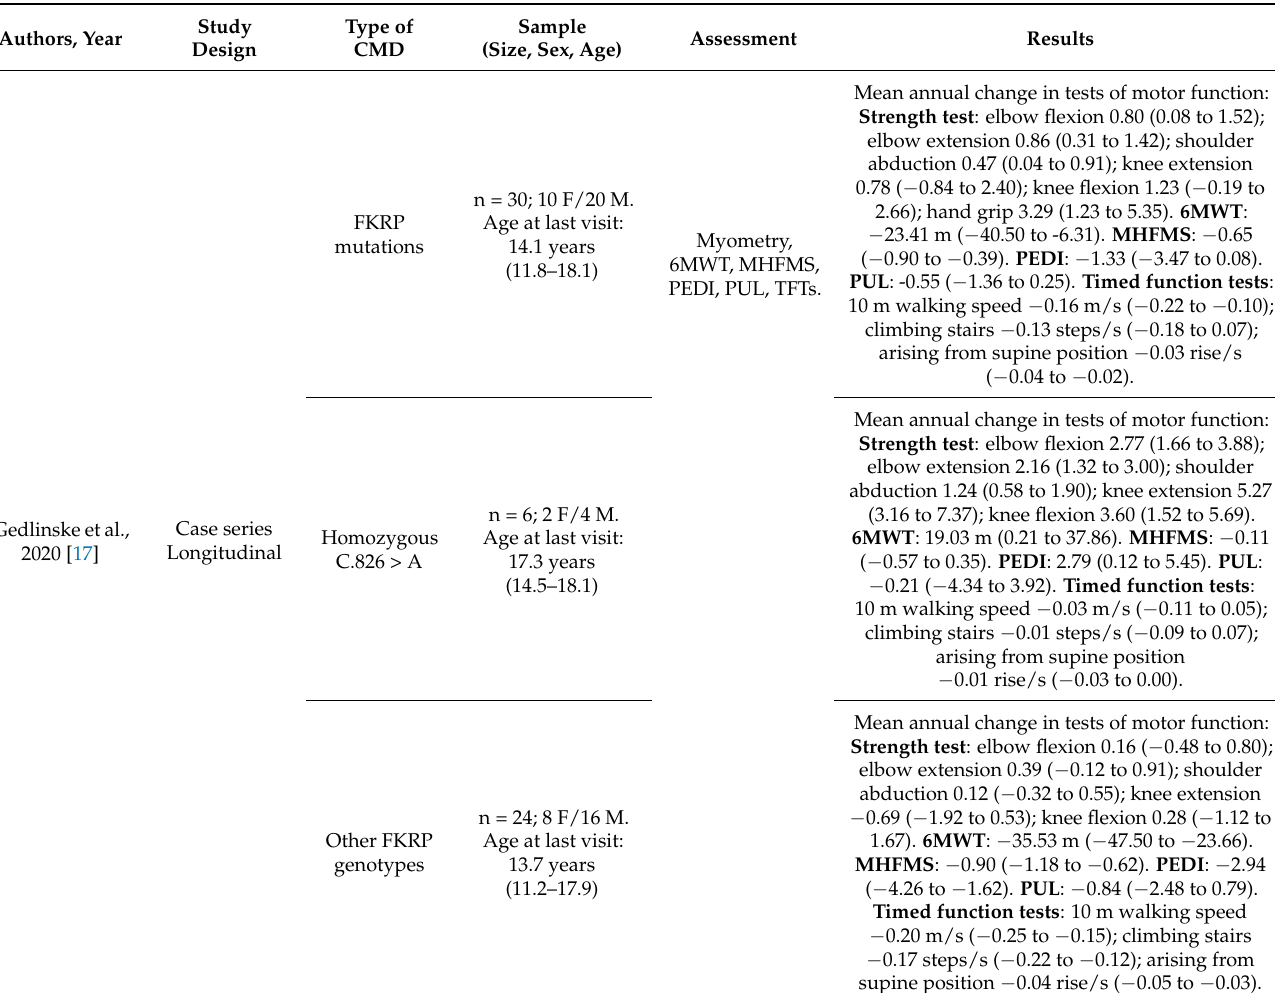
Table 6. Motor outcome measures in patients with FKRP mutations (6MWT: 6 min walk test; MHFMS: Modified Hammersmith Motor Function; PEDI: Pediatric Evaluation of Disability Inventory; PUL: Performance of Upper Limb; TFTs: timed function